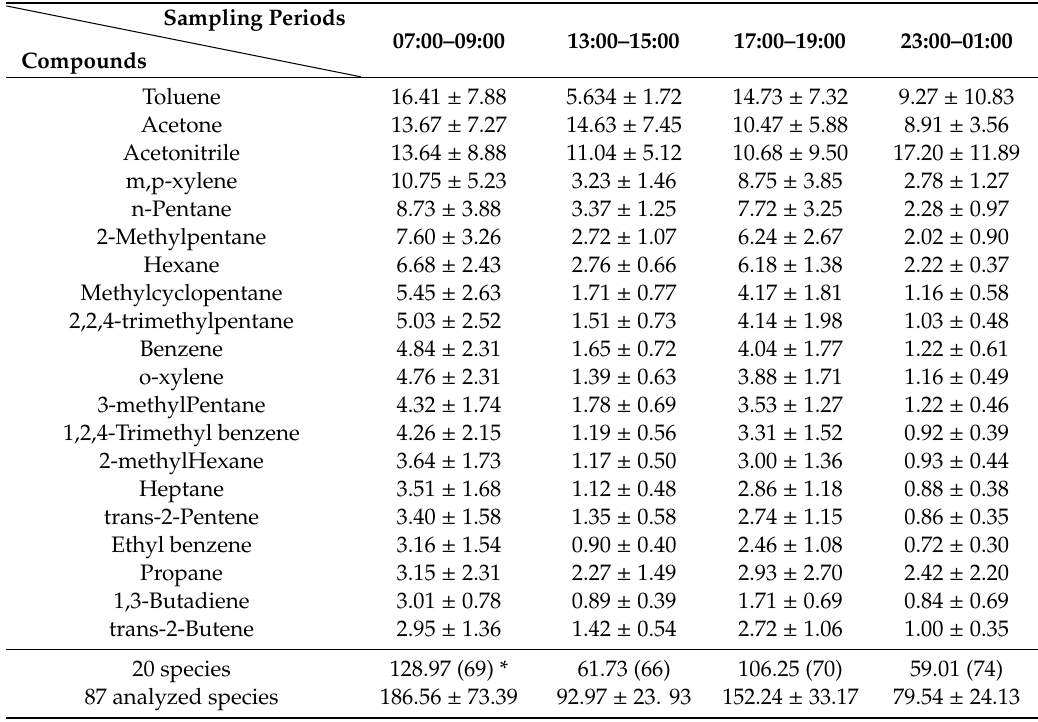
Table 1. VOC species concentrations (ppbv) at roadside sites.